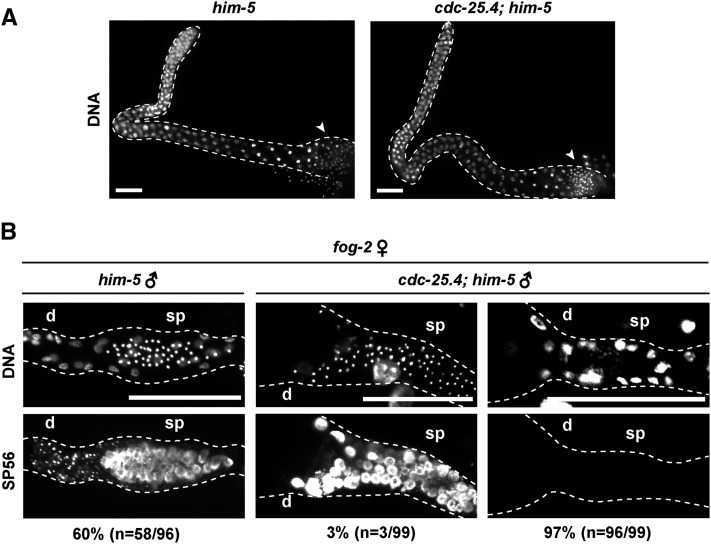
The majority of cdc-25.4(tm4088) males failed to transfer sperm to hermaphrodite uteruses. (A) DNA staining of male adult gonads. him-5(e1467) (n = 45) and cdc-25.4(tm4088); him-5(e1467) (n = 57) male adults were dissected and their gonads were stained with a DNA fluorescent dye, Hoechst 33342. Spermatids (arrowheads) were observed normally in the proximal region of cdc-25.4(tm4088); him-5(e1467) male gonads as compared with him-5(e1467) male gonads. Scale bars, 20 μm. (B) After mating with either single him-5(e1467) males or single cdc-25.4(tm4088); him-5(e1467) males, each fog-2(q71) hermaphrodite was dissected and the proximal region of the gonad was immunostained with a sperm-specific monoclonal antibody, SP56, along with Hoechst 33342 to visualize DNA. Scale bars, 50 μm. d, distal side of the gonad; sp, spermatheca.